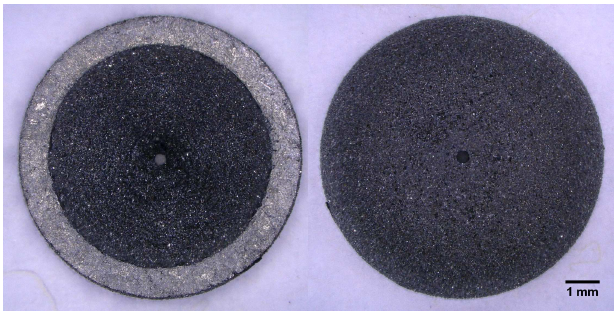
Figure 11. Optical microscopy of the laser-sintered hemisphere, bottom ( Left ) and top ( Right